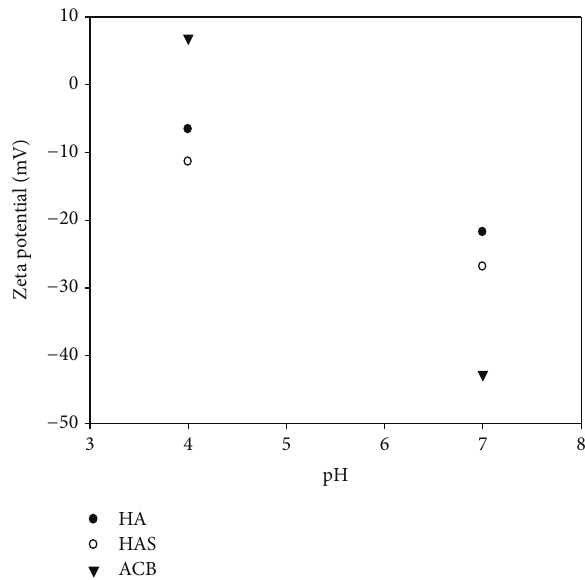
Figure 3: Zeta potential ( 𝑍𝑝 ) obtained for the adsorbents hydrox- yapatite (HA), synthetic hydroxyapatite (HAS), and active babassu coal (ACB) at pH 4.0 and pH 7.0 and 25 ∘